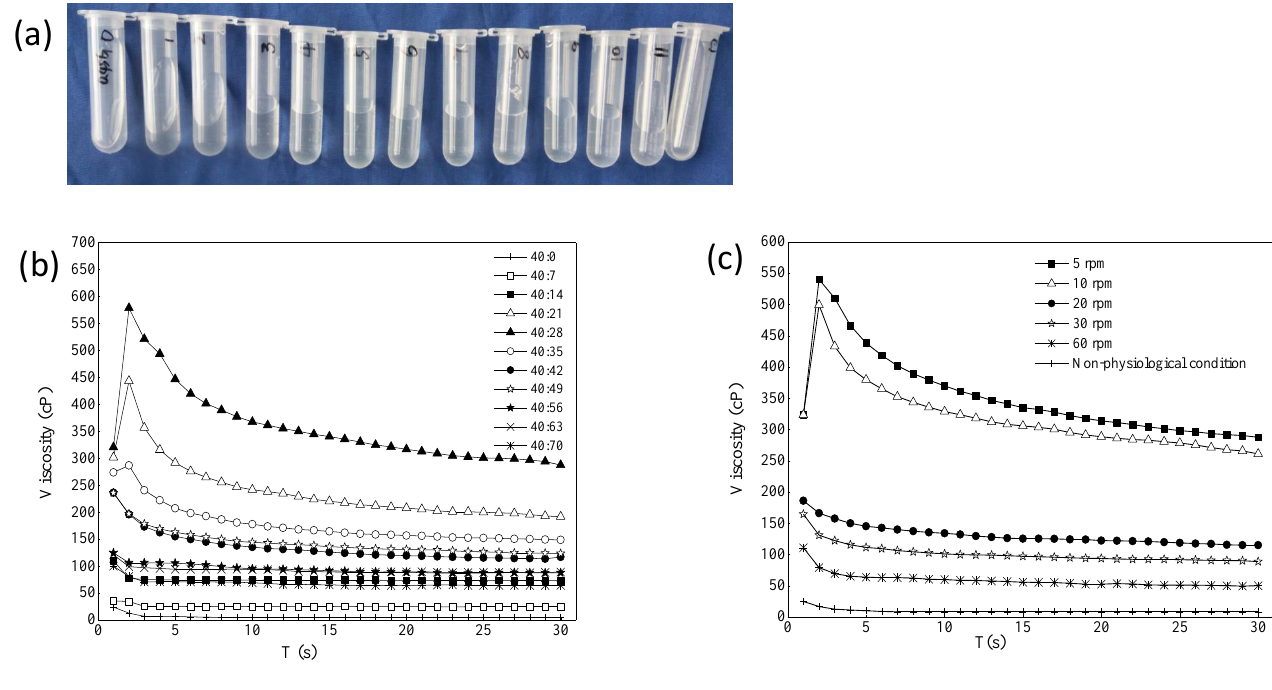
Figure 4. ( a ) 0.45% Gellan gum mixed with artificial tears in different ratios (from left to right: 0.45% gellan gum/STF from 40:0, 40:7, 40:14 to 40:84). ( b ) The effect of ion intensity on the viscosity of the optimal BRT-ISG (34 °C, 10 rpm, n = 4). ( c ) The effects of shear rate on the viscosity of the 0.45% gellan gum:STF = 40:28 (non-physiological was 25 °C, the other was 34 °C, n = 4).